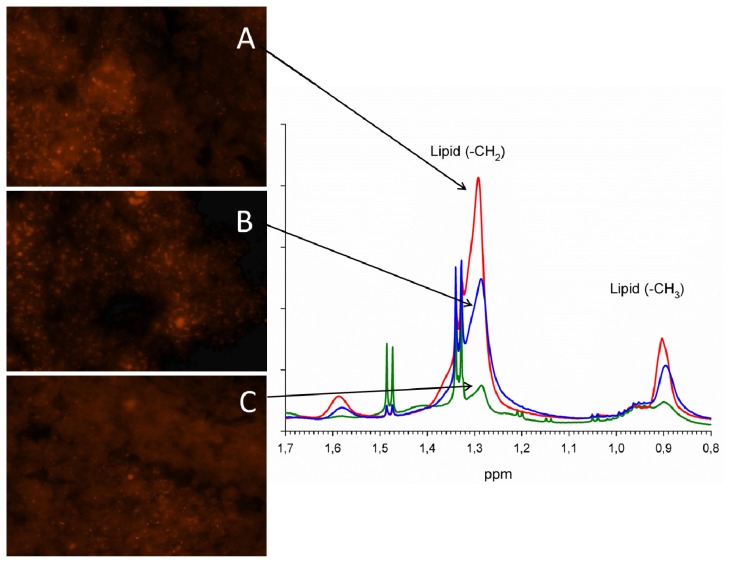
Nile Red fluorescent-stained images showing lipid droplets in three brain metastases originating from lung carcinoma (A, B, C) and their corresponding mean normalized single-pulse spectra (1.6–0.8 ppm), which demonstrate signal differences due to methylene (1.3 ppm) and methyl groups (0.9 ppm) in the mobile fatty acyl chains.